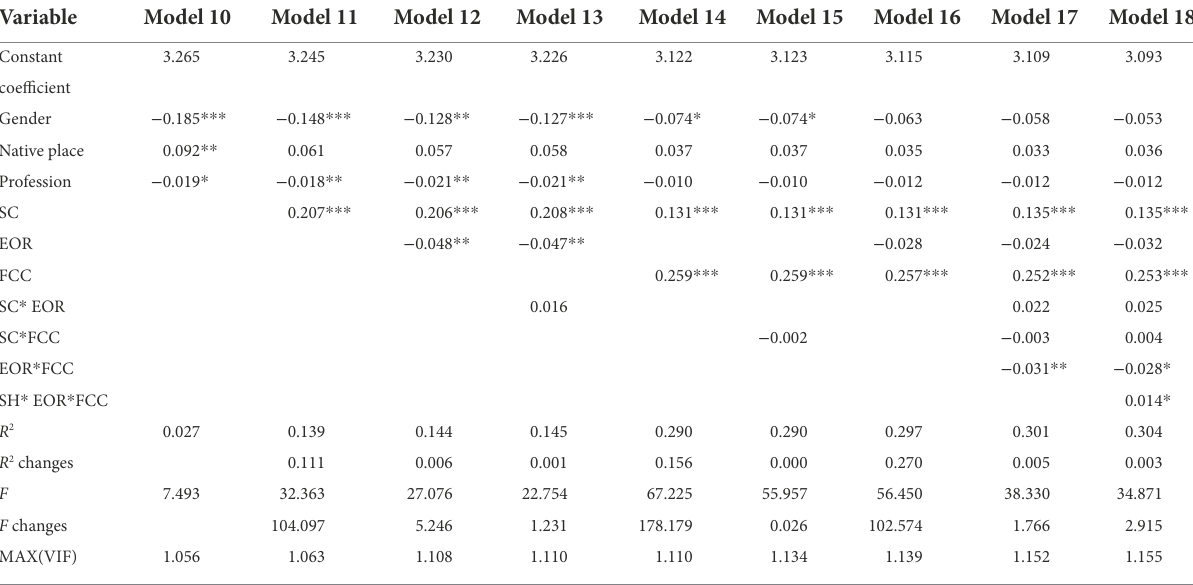
TABLE 4 The moderating effect of perception reduction of employment opportunities under the COVID-19 epidemic and future career clarity on social capital and employability. Dependent variable: